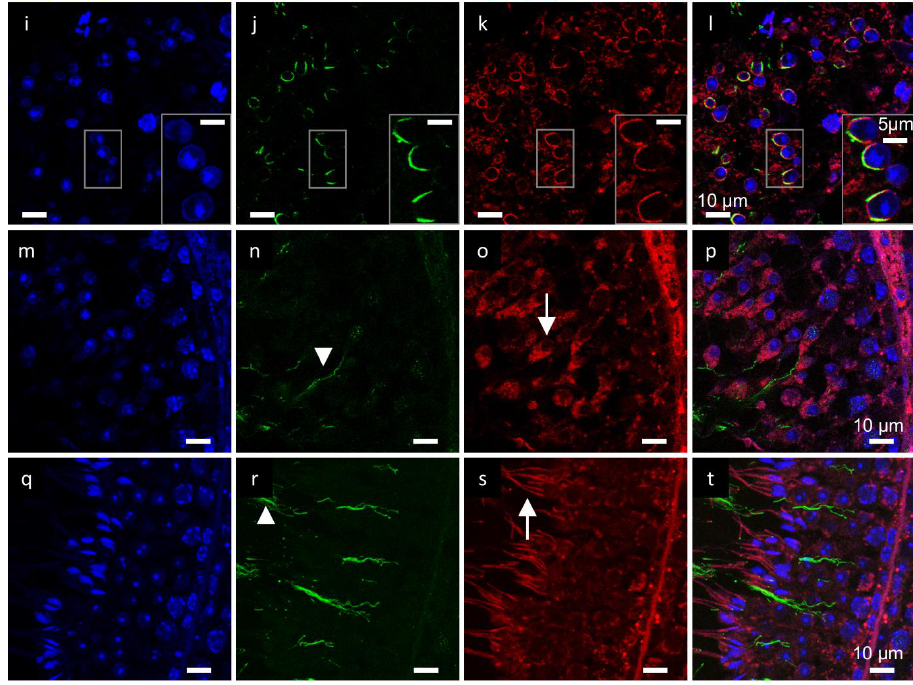
Figure 3. Double immunofluorescence of LAP1 and acetylated α-tubulin in mouse testis sections fixed in diluted Bouin’s solution. DAPI appears in blue, IgG mouse and acetylated α-tubulin in green, IgG rabbit and LAP1 in red. ( a – d ) Negative controls with mouse and rabbit IgGs showed some staining in the interstitial tissue through stages VIII–IX. ( e – l ) LAP1 polarizes at the NE with acetylated α-tubulin (ROI) at the beginning of spermatid elongation, during stages VIII–IX. ( m – p ) As elongation proceeds in stages IX–X, LAP1 appears homogeneously distributed in the cytoplasm of elongating spermatids ((o), arrow), while acetylated α-tubulin relocates to the axoneme ((n), arrowhead). ( q – t ) Upon spermatid maturation in stages VII–VIII, LAP1 concentrates along the midpiece of already elongated spermatids ((s), arrow), and acetylated α-tubulin remains in the flagellar axoneme ((r), arrowhead). LAP1: lamina-associated polypeptide 1; NE: nuclear envelope; ROI: region of interest.